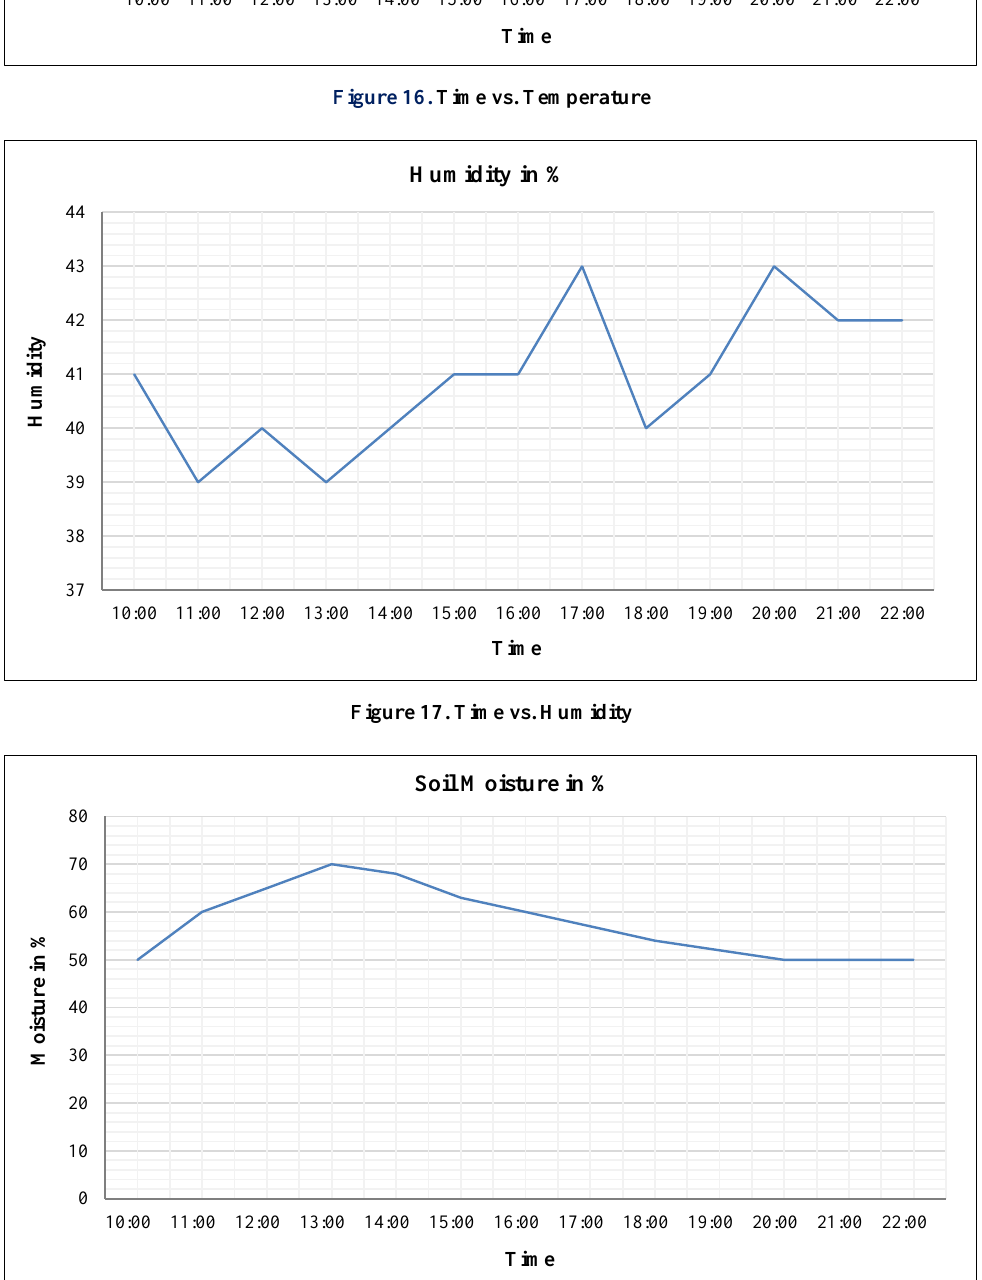
Figure 18. Time vs.